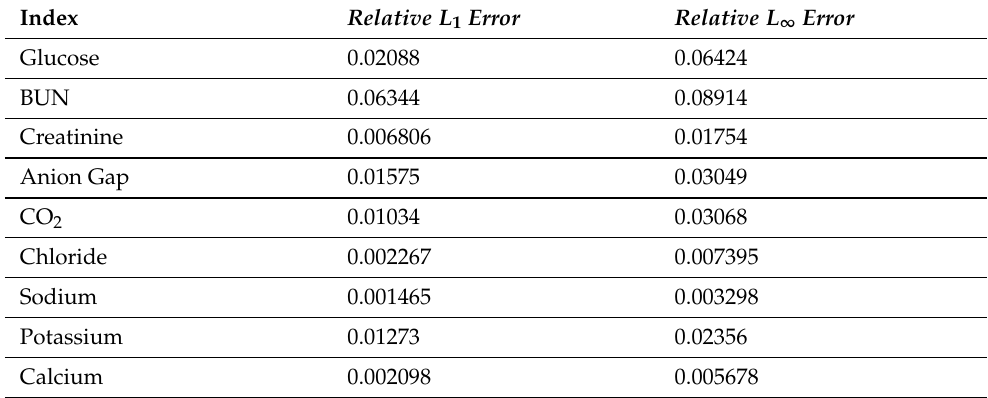
Table 4. Relative errors for all 9 indices of the metabolic panel in the LSTM model with T =